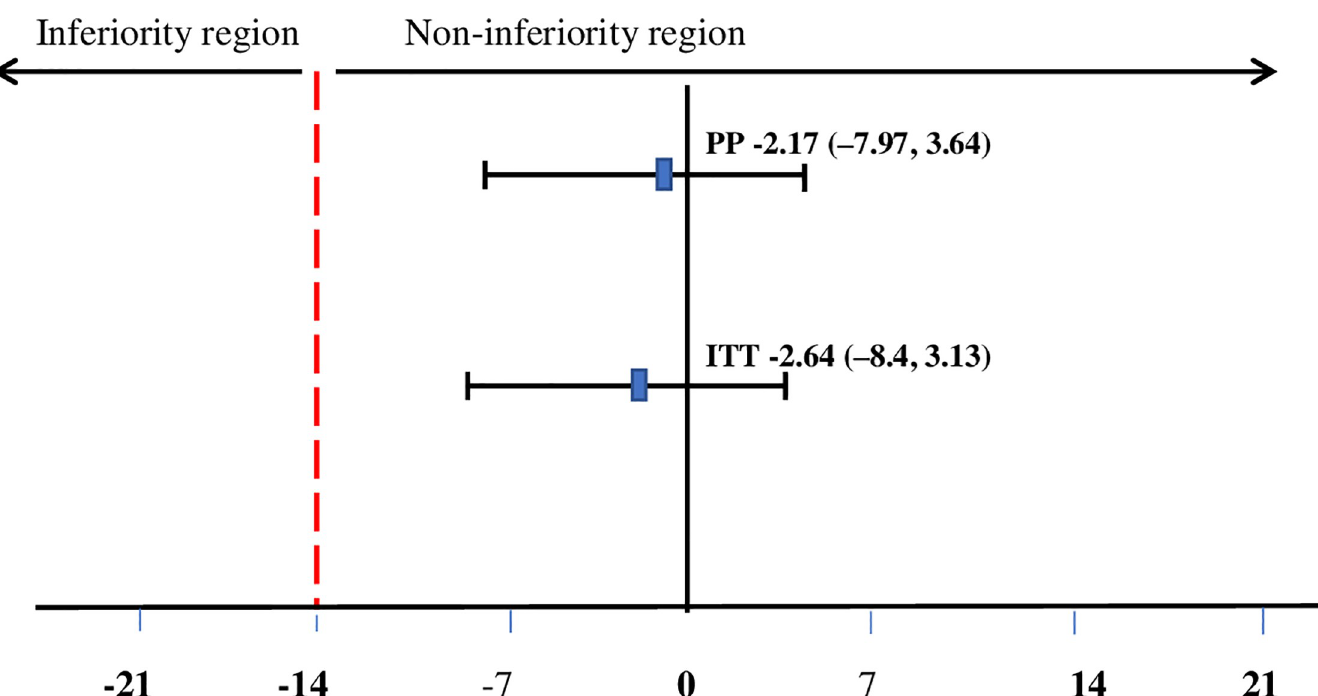
Fig 4. Difference in recovery time in days between LIBS and CSB+ groups. The recovery time in the LIBS group was non-inferior compared with the CSB+ group. Numbers are risk differences of recovery time in days between groups. The dotted line indicates the predefined non-inferiority margin. Abbreviations: LIBS: local- ingredients-based supplement; CSB+: corn-soy blend plus; PP: per-protocol; ITT: intention to treat. The generalized estimating equation was